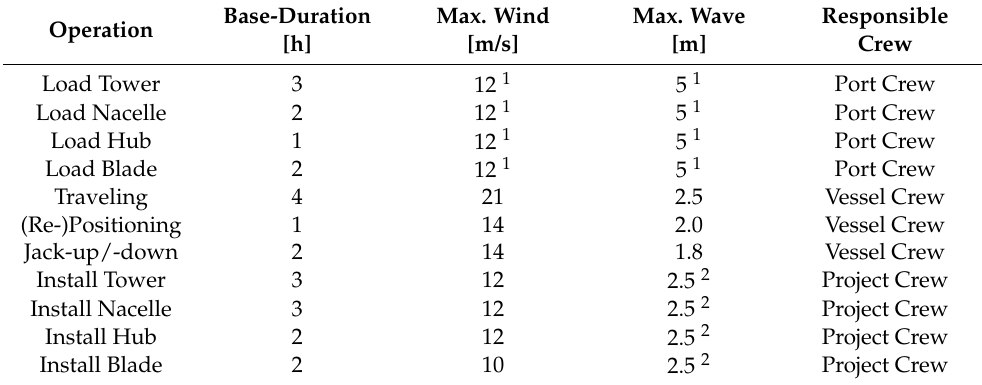
Table 1. Operations, limits, and durations—extended from Reference